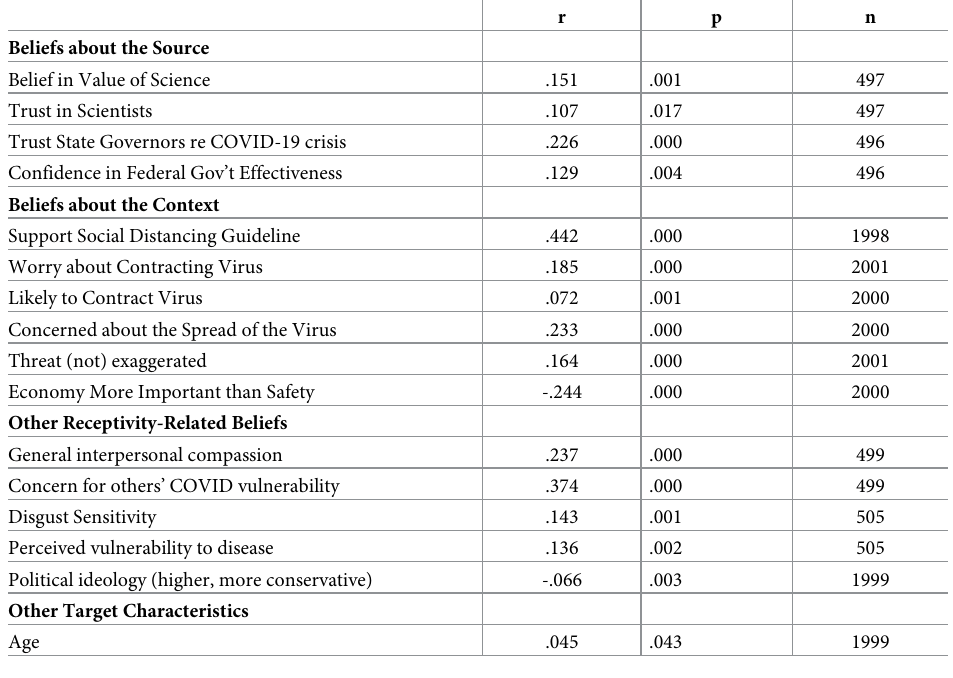
Table 4. Correlations with the residual predicting self-report measure of social distancing from the virtual behav- ior measure a .